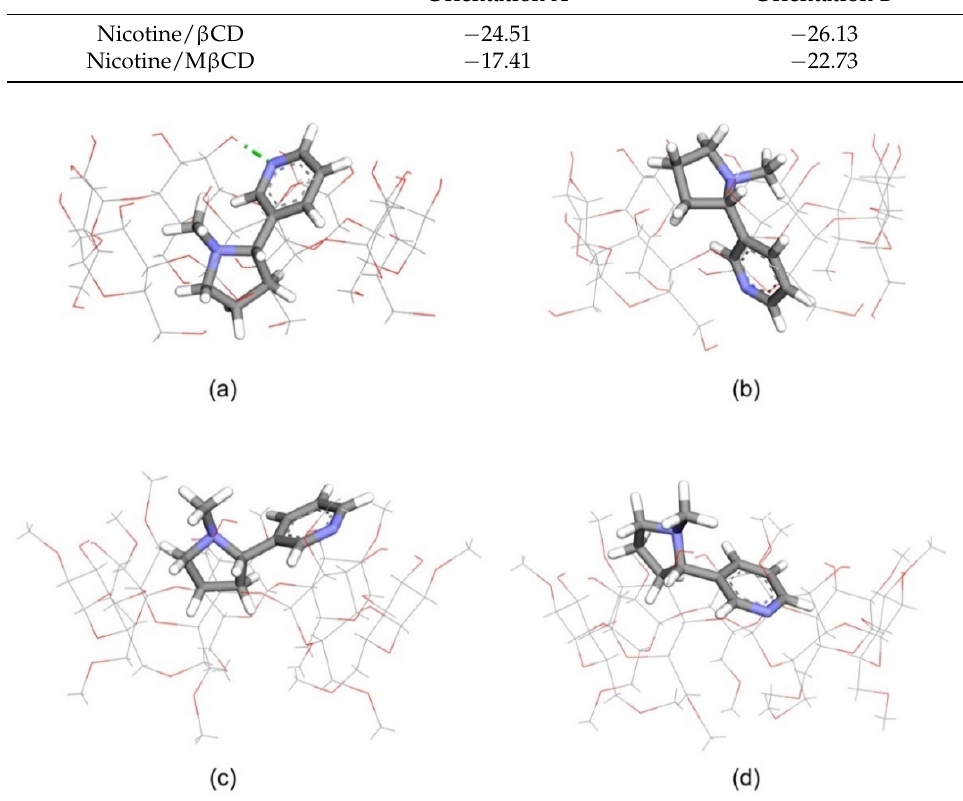
Figure 3. The minimized inclusion complex conformations: ( a ) nicotine/ β CD in orientation A, ( b ) nicotine/ β CD in orientation B, ( c ) nicotine/M β CD in orientation A, and ( d ) nicotine/M β CD in orientation B. β CD and M β CD are presented as a line model. The nicotine molecule is presented as a stick model. The green dashed line refers to a hydrogen bond.